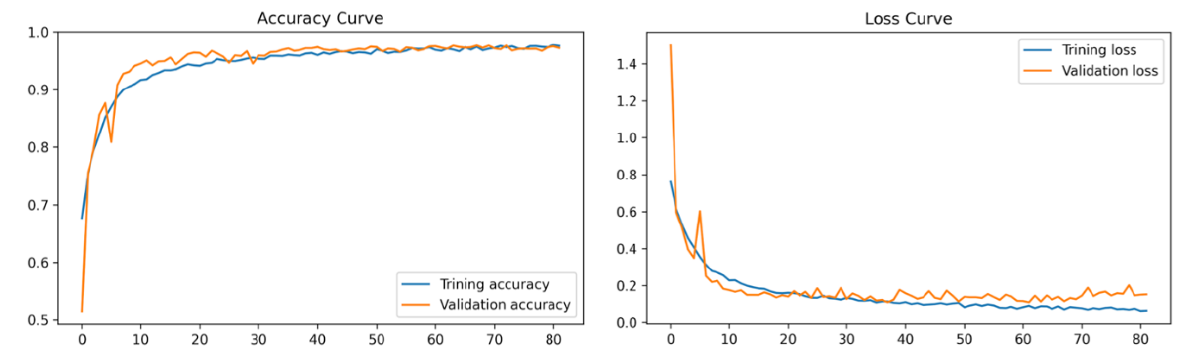
Figure 31. Accuracy and loss curves for CNN with LSTM and attention mechanism model trained on the clustering-based approach dataset.